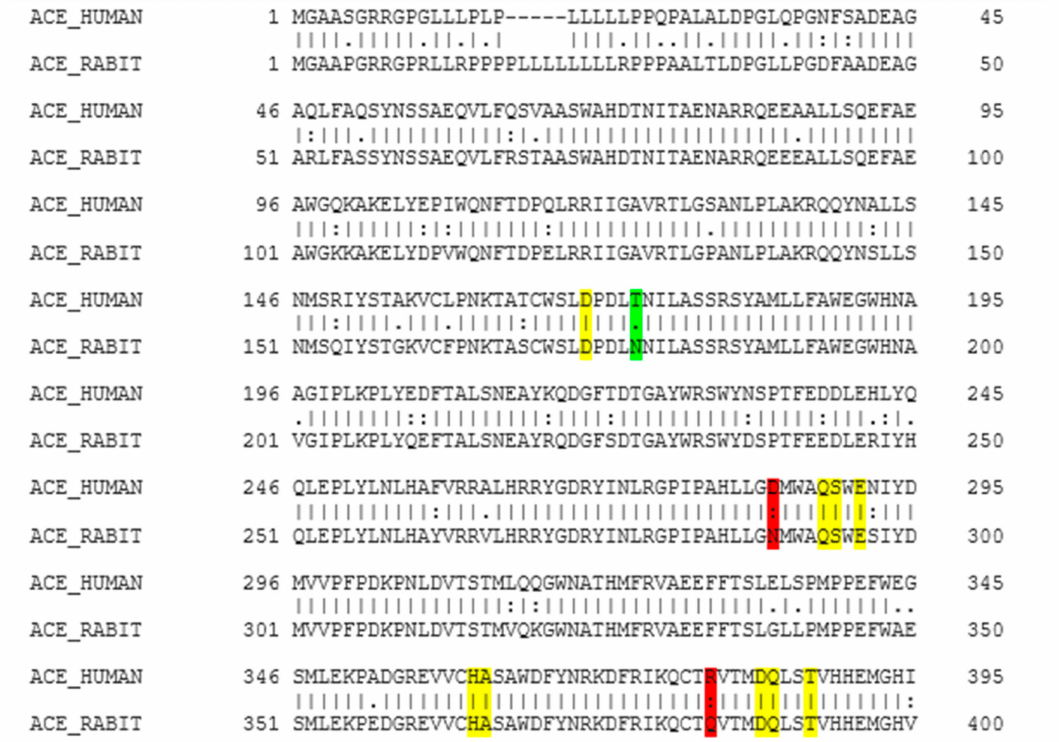
Figure 1. EMBOSS NEEDLE multiple sequence alignment results. Colour coding is as follows: Yellow indicates identical residues at the active site, green indicates similar residues at the active site, and red indicates that a part of the residue is similar. (I) residues are identical; (.) conserved change; (:) part of the residue is similar but not that